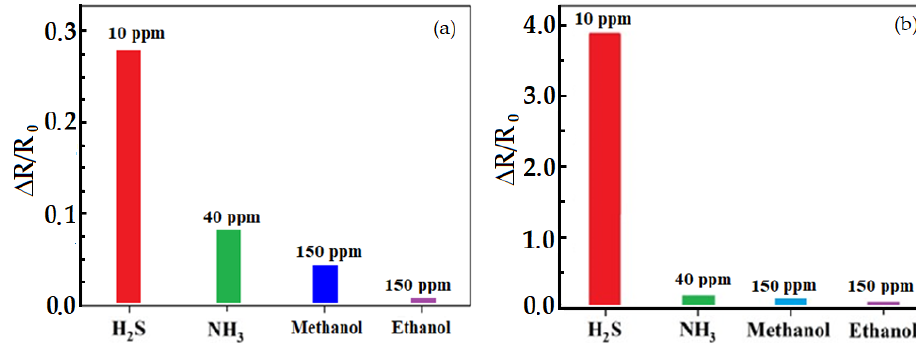
Figure 7. Selectivity of the sensors, prepared by ( a ) physical and ( b ) chemical methods.